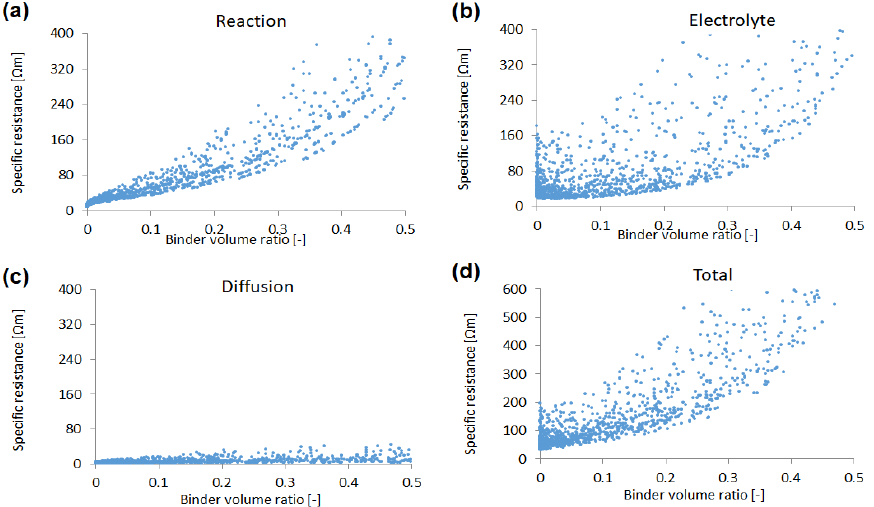
Figure 6. Sensitivities of ( a ) reaction resistance, ( b ) electrolyte resistance, ( c ) Li diffusion resistance, and ( d ) total specific resistance to the binder/additives volume ratio, with a total of 2100 simulation results.